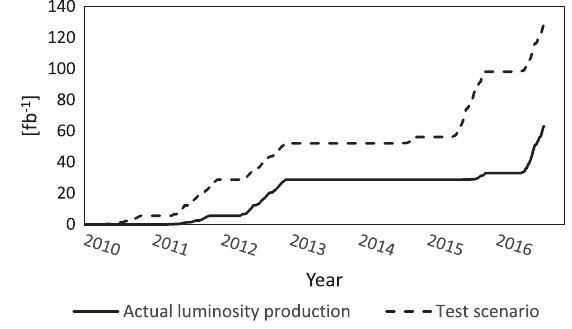
FIG. 13. The actual LHC production compared to a scenario with less nonproductive time.